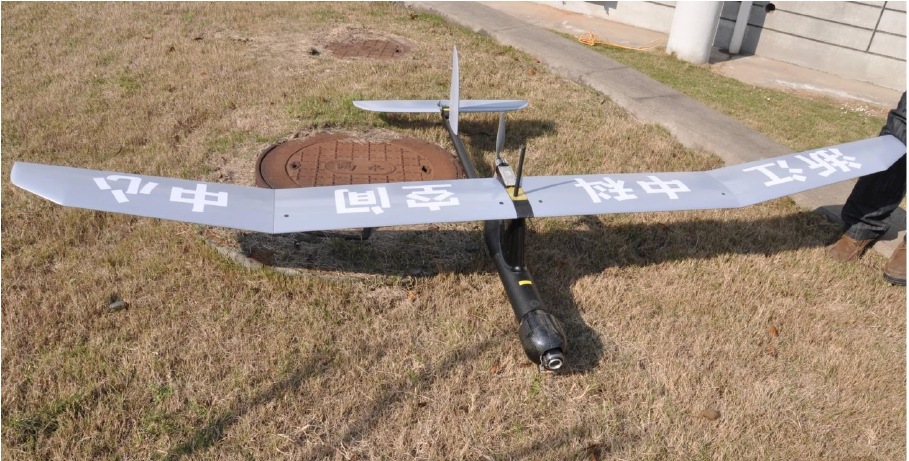
Figure 4. River-Map